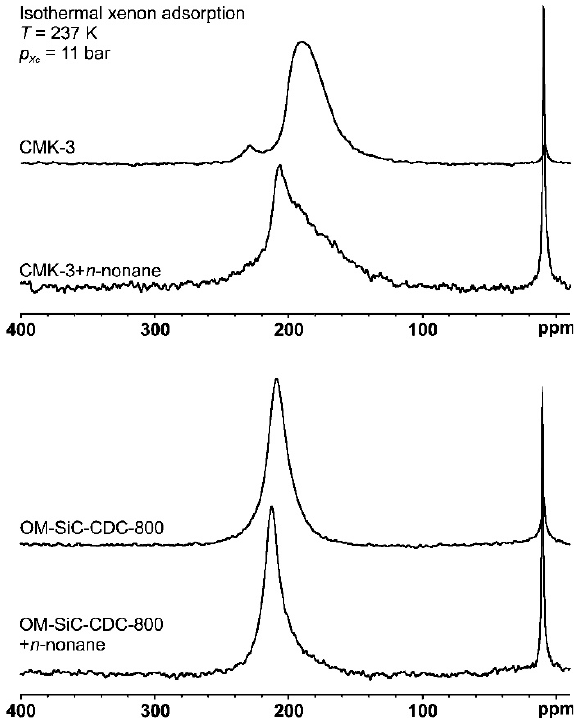
Figure 12. 129 Xe NMR spectra of CMK-3 and an ordered mesoporous carbide-based material, taken before and after adsorption of n ‐ nonane. Reprinted with permission from reference [121]. Copyright 2014 American Chemical Society.